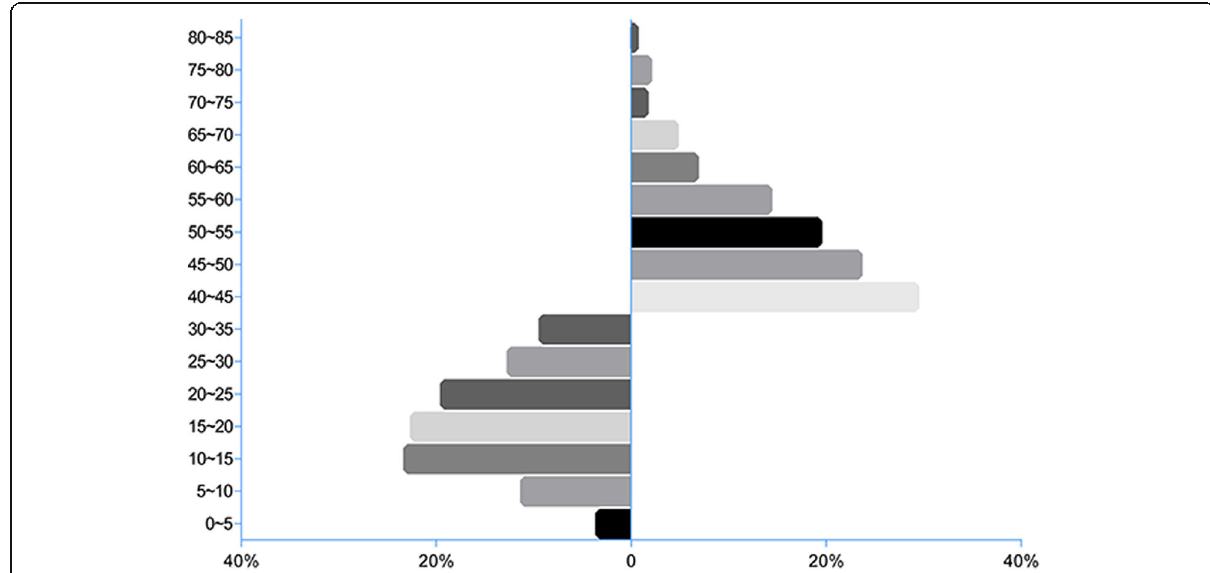
Fig. 2 The proportional distribution of the binaural average hearing threshold levels (HTLs) at 3 kHz,4 kHz,6 kHz in case and control groups. HTL is grouped by 5 dB(A) in both case and control groups. The control group ranges from 0 to 35 dB(A) and the case group is in the range of 40 to 85 dB(A)